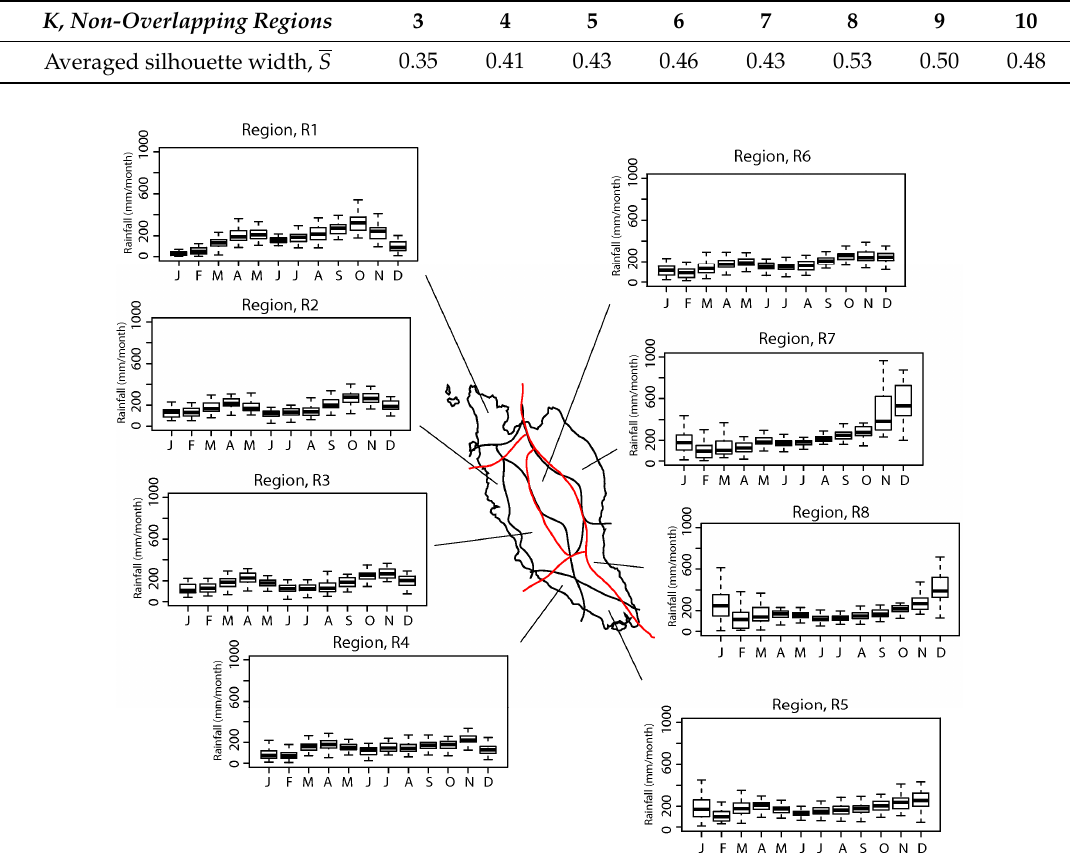
Figure 1. Box and whisker plot of areal average mean monthly rainfall (1976–2006) of the eight delineated rainfall regions in Malaysia. The solid line is the median, the height of the box is the difference between the third and first quartiles (IQR). The zones delineated by Lim [5] are shown in red lines.